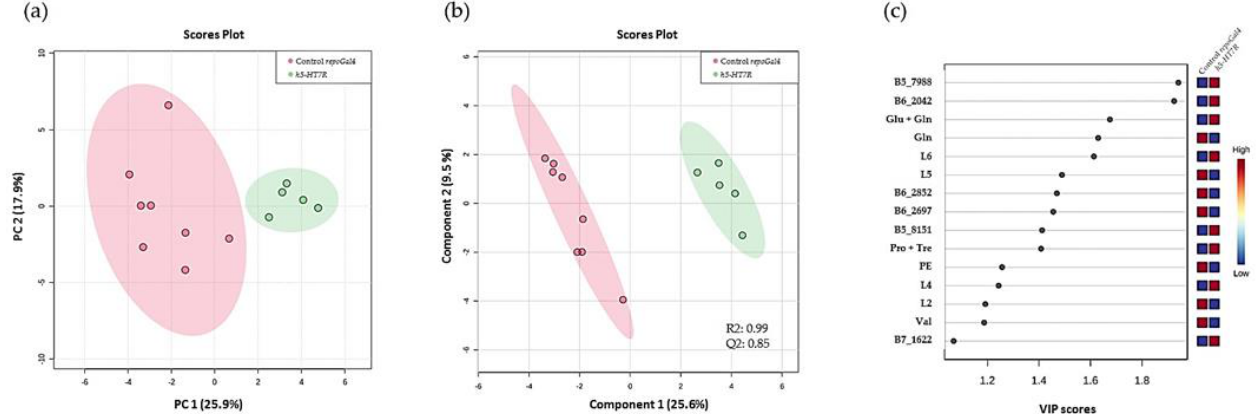
Figure 7. HR-MAS based metabolomics results. Comparison of controls brains ( repo-Gal4 ) and brains expressing h5-HT 7 R alone. ( a ) Unsupervised multivariate analysis PCA, ( b ) score plot of the PLS–DA of the repo-Gal4 control brains and the brains expressing h5-HT 7 R. The Q2 indicates the quality of the prediction, ( c ) VIP scores for the first 15 buckets and their relative concentration in the two groups. Glu: glutamate; Gln: glutamine; PE: phosphoethanolamine; Pro: proline; Tre: trehalose; Val: valine. L2, L4, L5 and L6: fatty acids. L2: (CH 2 ) n ; L4: CH 2 -C=; L5: CH 2 -CO; L6: CH=CH. Red: high level, blue: low level.